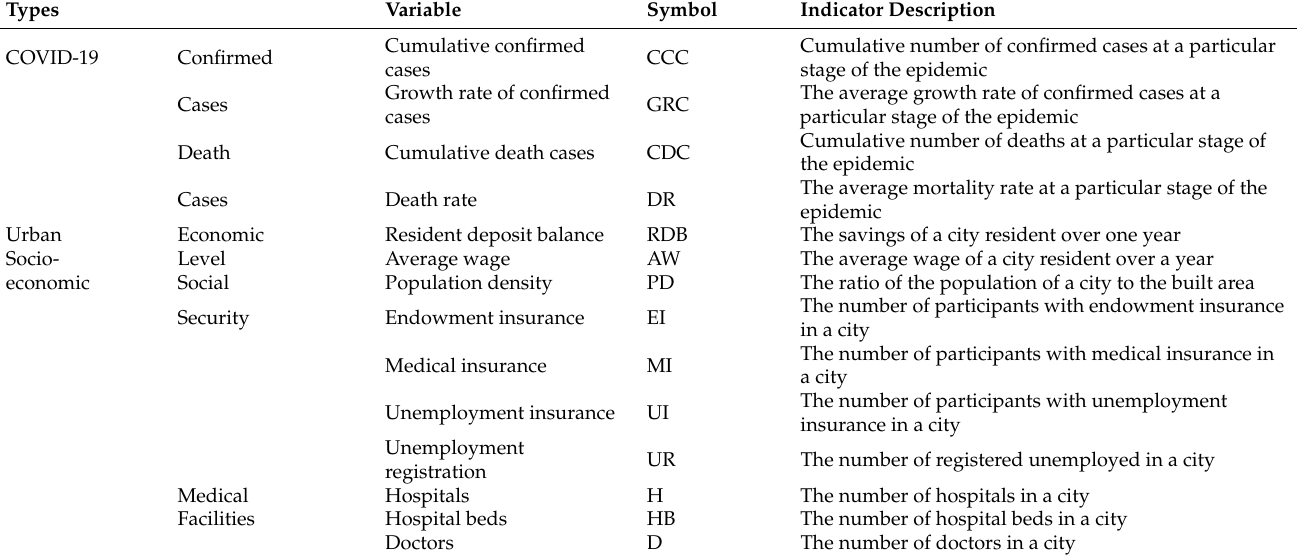
Table 1. Qualitative description of each index.